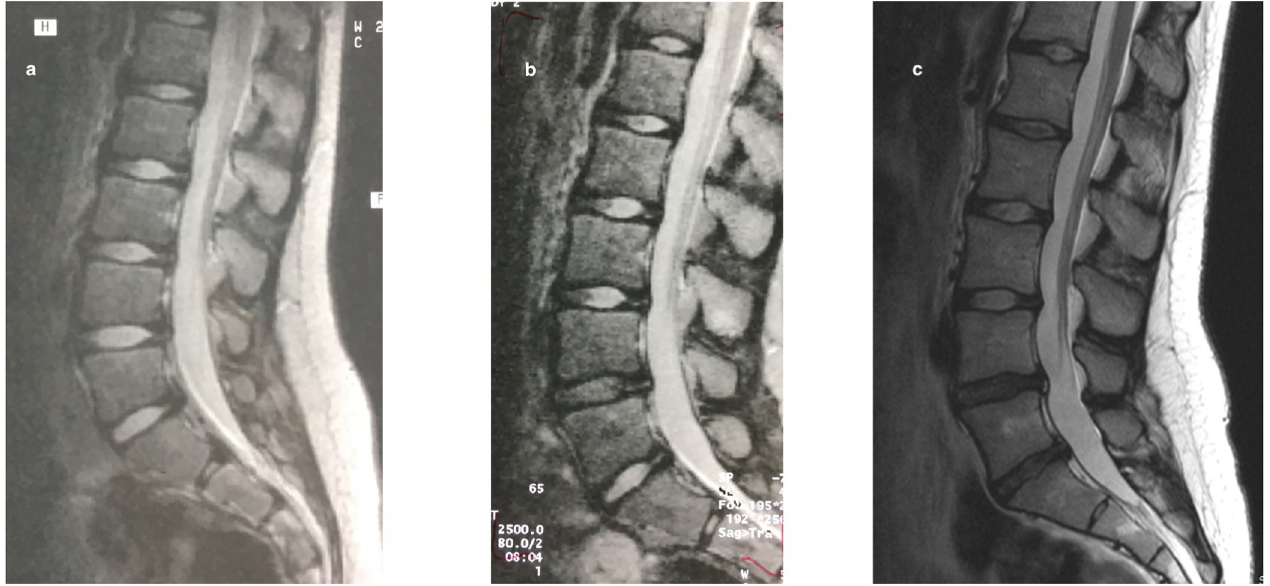
Fig 2. The evolution of disc changes throughout the study period in one study participant. The MRI images illustrate the visual assessment of the signal intensity (SI) of the intervertebral disc using the Schneiderman classification. At Y8, all lumbar discs presented with a Bright nucleus pulposus (a). At Y12, the L4/L5 disc was graded Speckled (b), and at Y19, both L4/L5 and L5/S1 discs were graded Dark